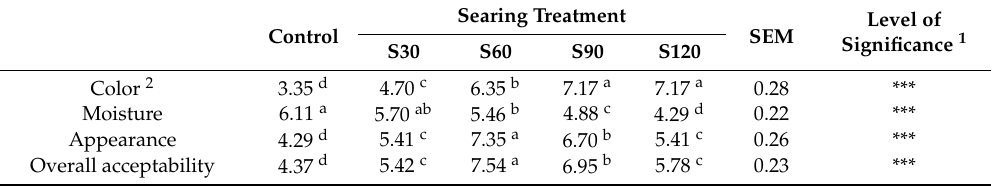
Table 3. E ff ects of searing process on visual attributes of sous-vide cooked pork